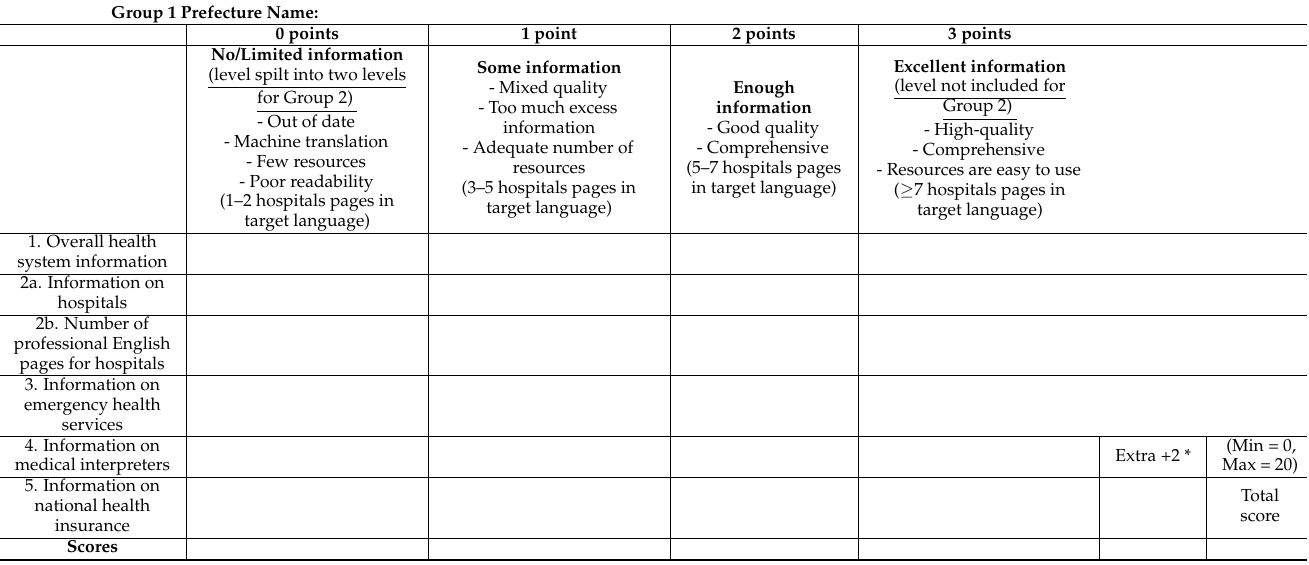
Table 1. MHCIE framework adapted for use in assessing information